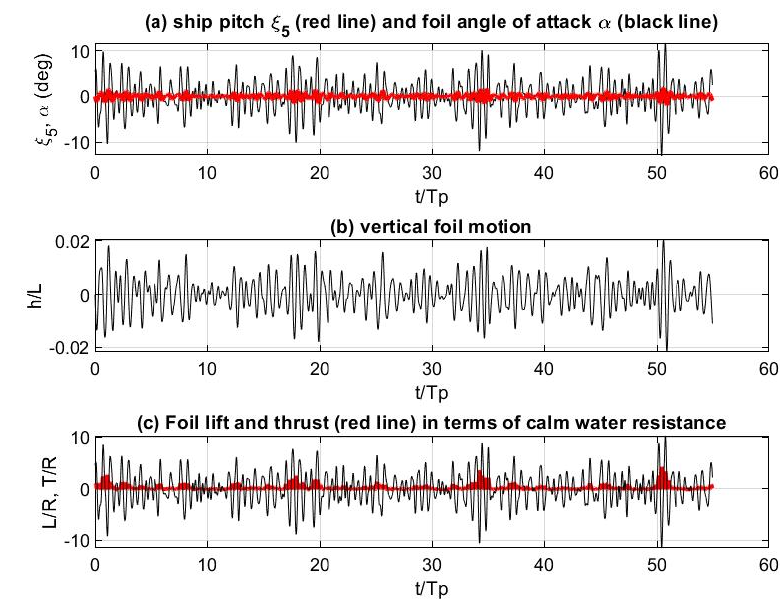
Figure 11. Realization of the vertical motion of the foil (solid line) at the bow of the ship at Fr = 0.25 in comparison with the ship heave motion (dashed line) for the head waves propagating at β = 180° and represented by the spectrum of Figure 10.